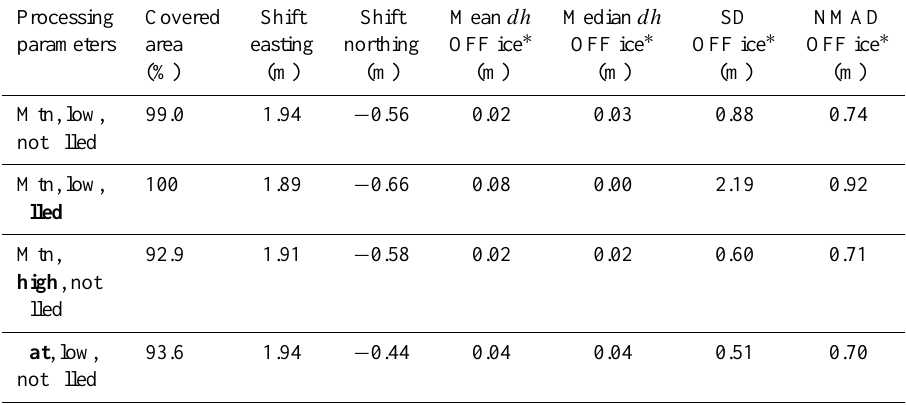
Table 2. Influence of different processing parameter settings on the coverage and accuracy of the Pléiades DEMs. Statistics for the elevation differences between the Pléiades and lidar DEMs are computed for ∼ 3000000 data points on the ice-free terrain around the Tungnafell- sjökull ice cap (Iceland). The parameter settings tested are as follows: type of terrain is mountainous (Mtn) or flat, DEM detail is low or high, data gaps are filled or not filled. All Pléiades DEMs are computed using 5 GCPs and with a final pixel size of 4m. The table provides the horizontal shifts of the Pléiades DEMs and, after horizontal co-registration (i.e. correction of the mean horizontal shift between the Pléiades and the lidar DEMs on the ice-free terrain), statistics (mean, median, SD and NMAD) of the elevation differences ( dh , Z Pléiades − Z lidar ) outside the ice cap (OFF